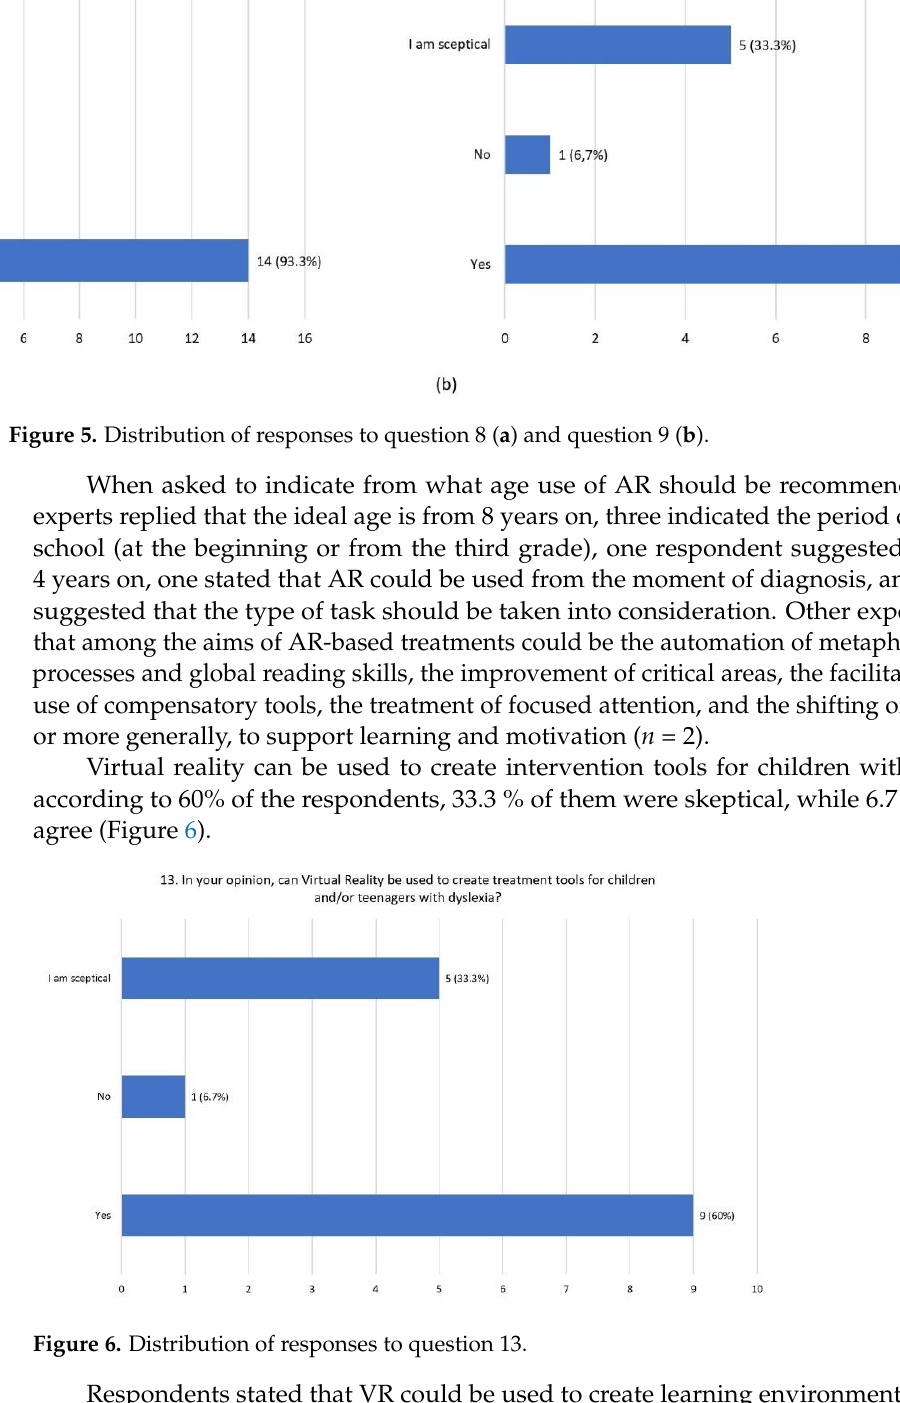
Figure 6. Distribution of responses to question 13.